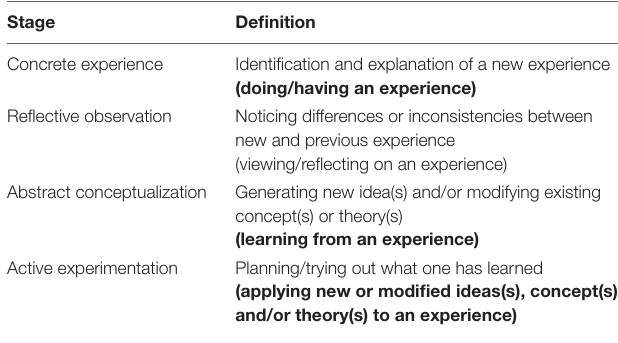
TABLE 1 | Kolb and Kolb’s (2005) ELT stages and authors’